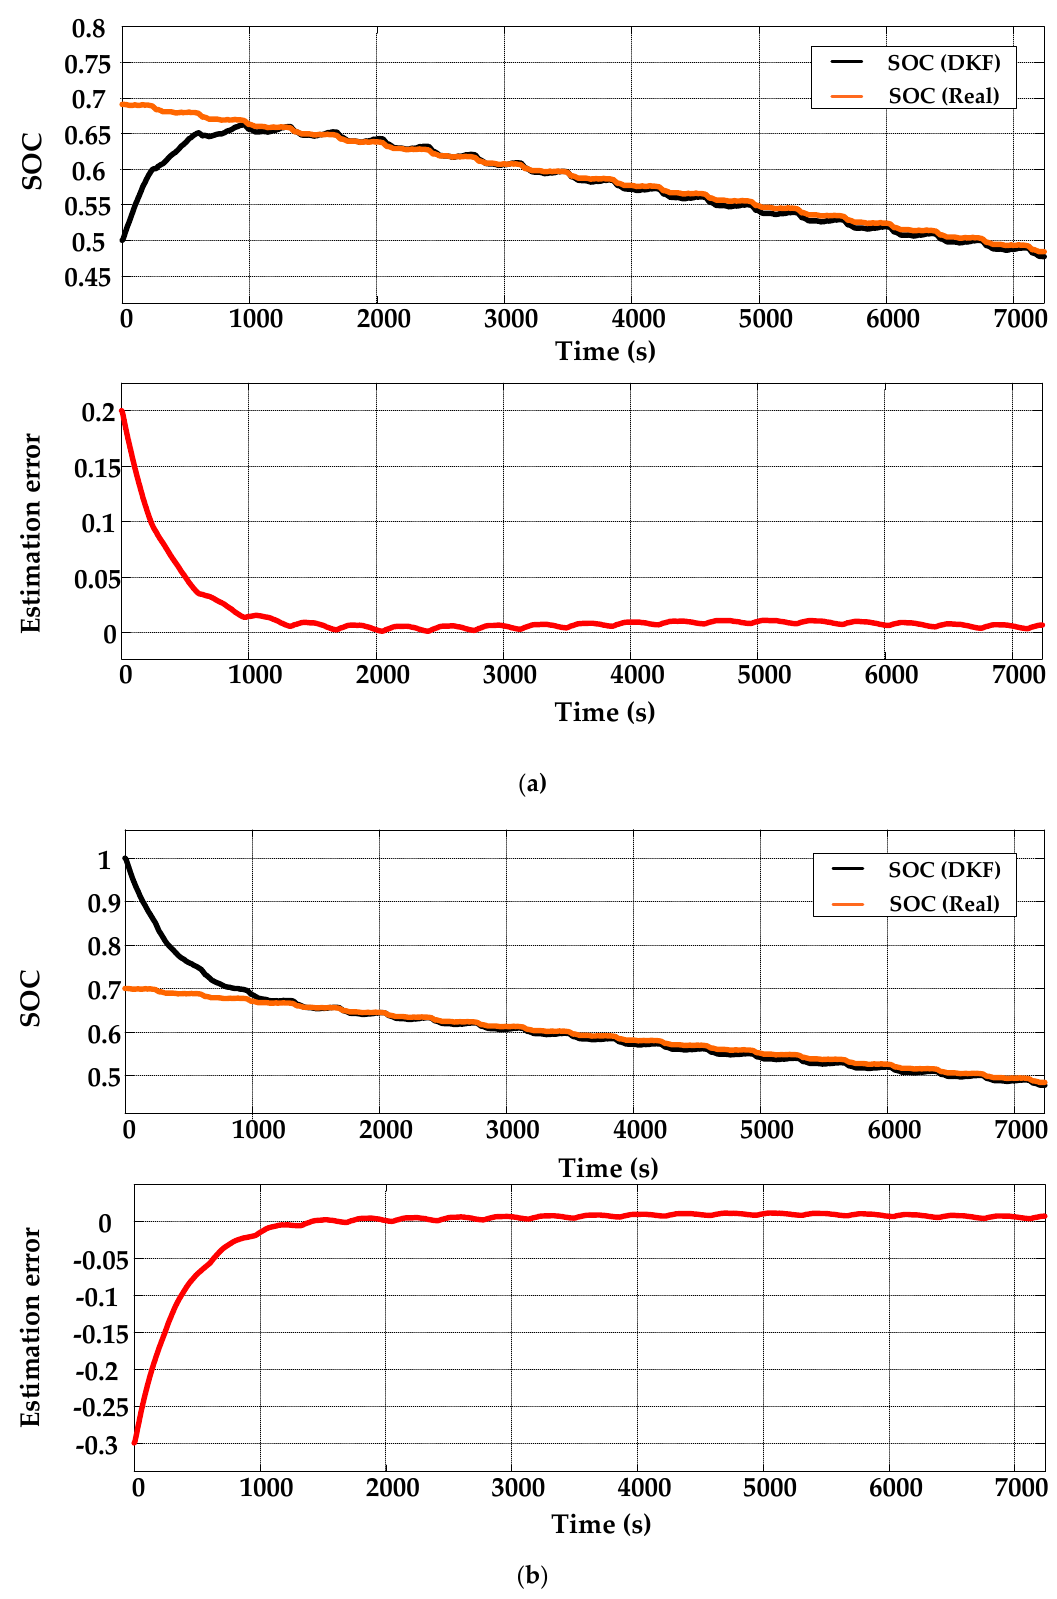
Figure 13. Algorithm verification results with initial SOC errors: ( a ) estimated SOC and corresponding estimation error with an initial SOC value of 0.5, ( b ) estimated SOC and corresponding estimation error with an initial SOC value of 1.